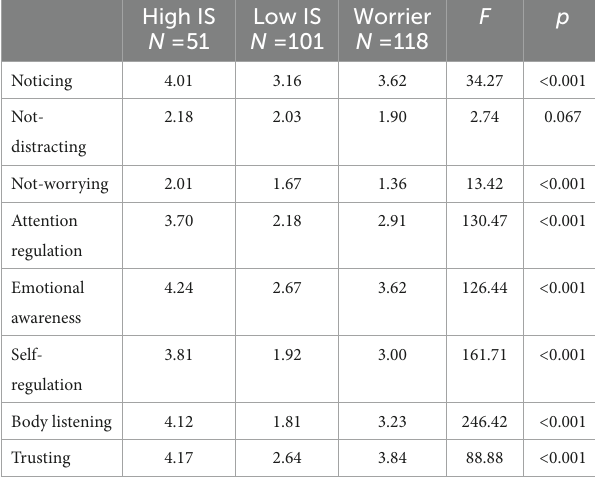
TABLE 2 Final centroids of three MAIA clusters.